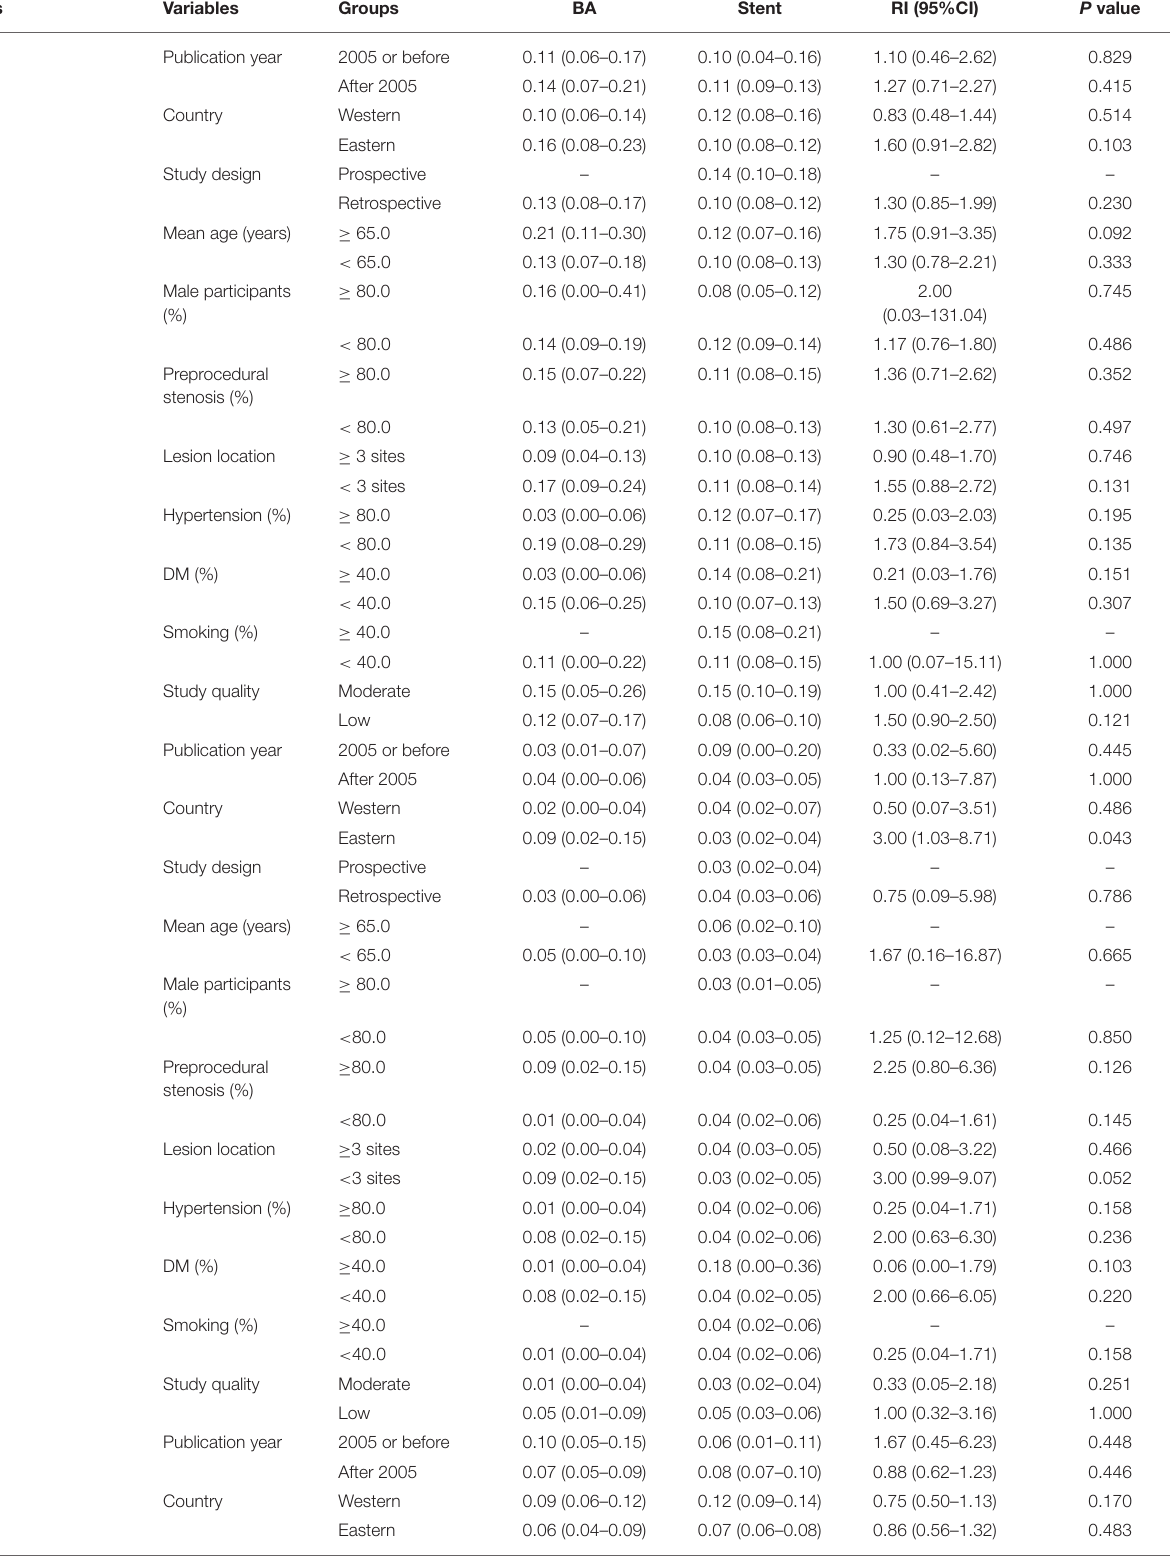
TABLE 2 | Outcomes for balloon angioplasty vs. stenting according to study or patients’ characteristics.